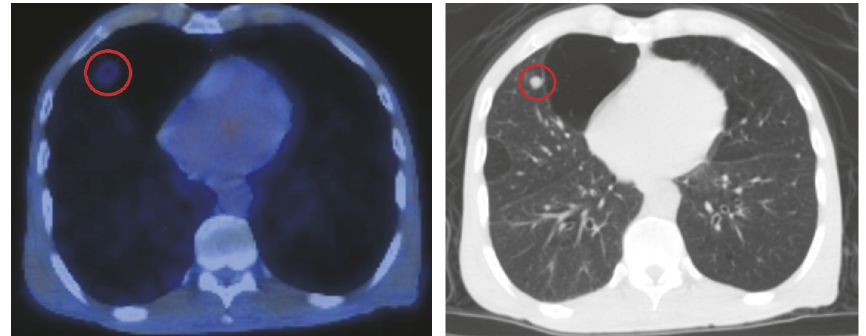
Figure 5: PET/CT shows a hypermetabolic spiculated lung nodule in the right middle lobe. There is background severe bullous emphysema.